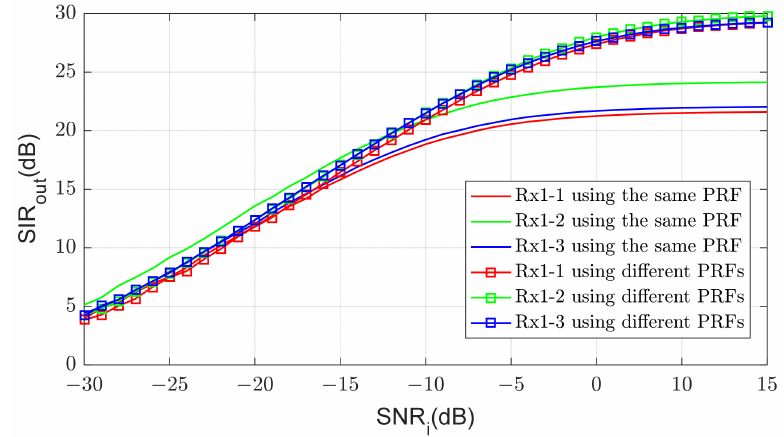
Figure 12. Output SIR out vs. input SNR i .